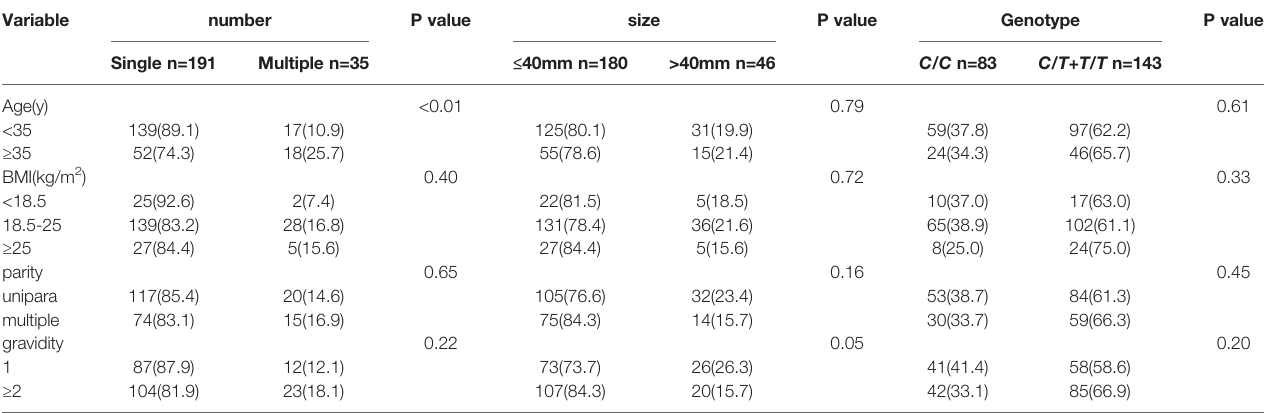
TABLE 4 | The in fl uence of different demographic characteristics on the incidence of UF in the case group (n=226). Variable number P value size P value Genotype P value Single n=191 Multiple n=35